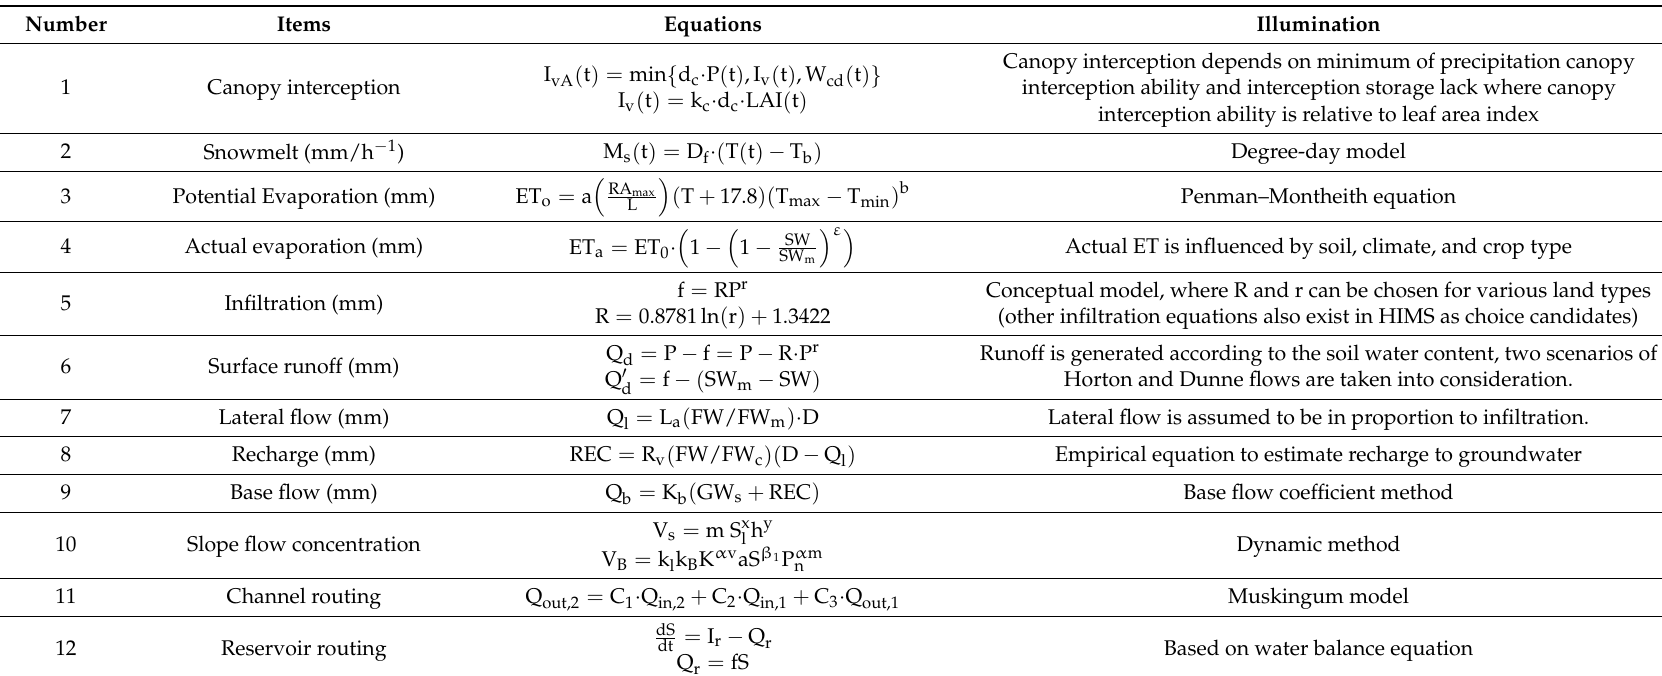
Table 1. Main equations of the customization HIMS